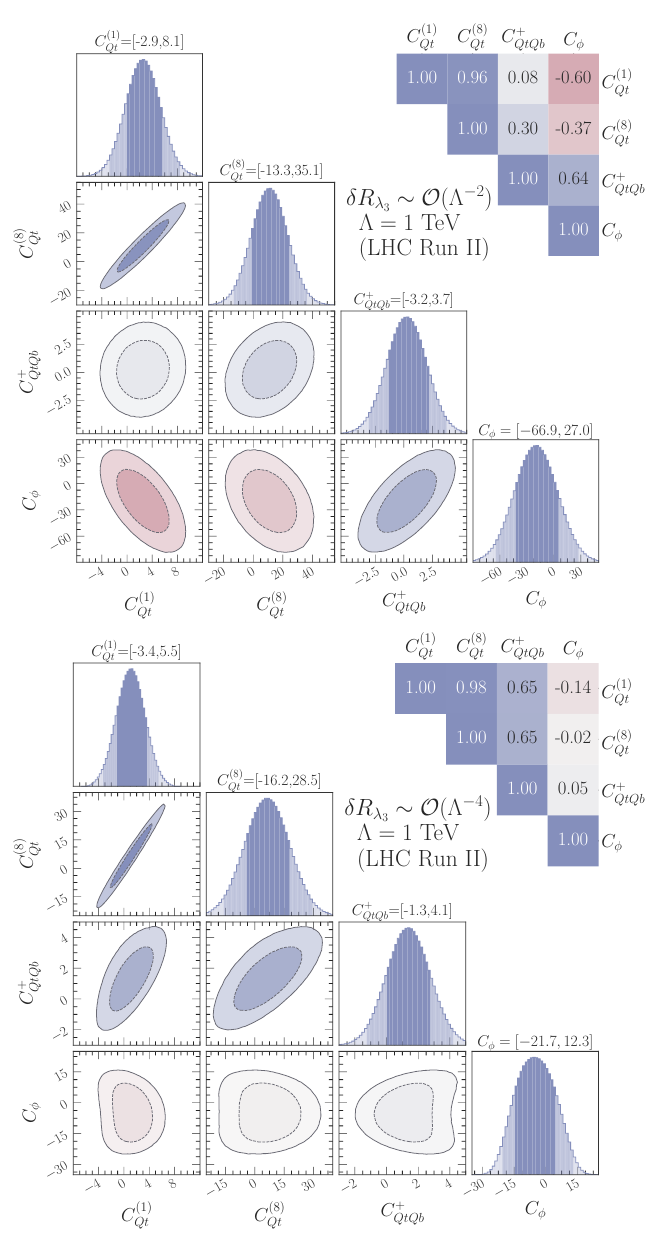
Figure 7 . The marginalised 68% and 95% high density posterior contours and HDPI’s for the four-parameter fits including the different four-quark Wilson coefficients and C φ . The numbers above the plots show the 95% CI bounds while the correlations are given on the top-right corner. These limits correspond to values of the Wilson coefficients evaluated at the scale Λ = 1 TeV. The upper panel shows the fit including terms up to O (1 / Λ 2 ) in δR λ , while the lower one shows the fit 3 with including also O (1 / Λ 4 )